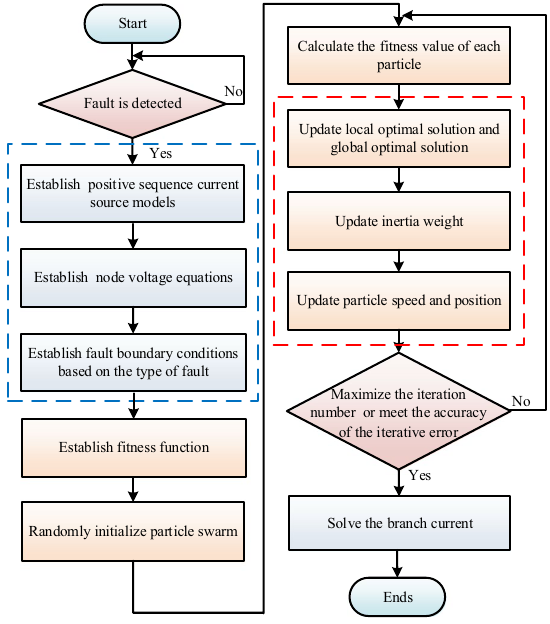
Fig. 3 Flow chart of the proposed fast‑iterative calculation method